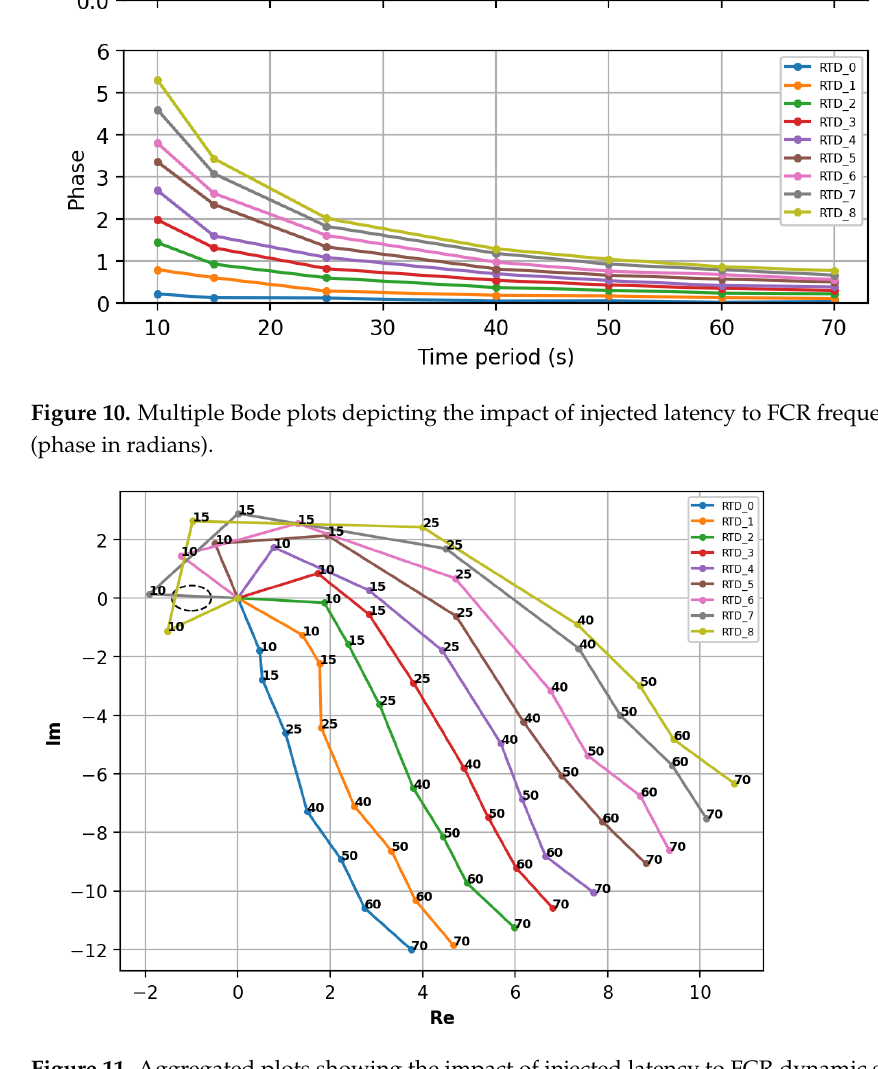
Figure 11. Aggregated plots showing the impact of injected latency to FCR dynamic stability. Each point in the complex plane describes the open loop frequency response for an input signal with the time period indicated by the annotation attached to the